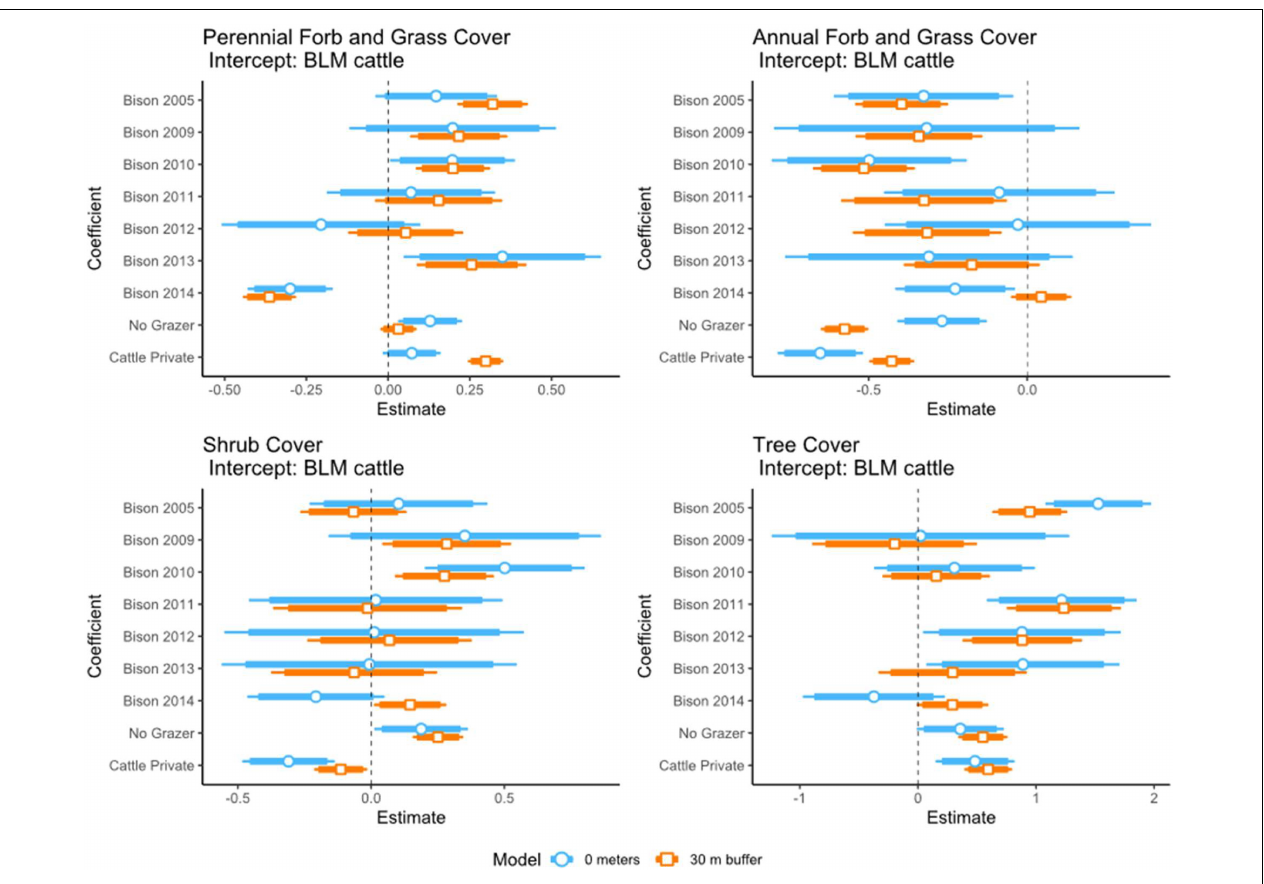
FIGURE 2 | 2019 percentage of vegetation cover in relation to grazing treatment. Intercept: BLM cattle grazed streams. Vegetation: perennial forbs and grasses, annual forbs and grasses, shrub cover, and tree cover. Treatment: BLM cattle, Bison (2005, 2009, 2010, 2011, 2012, 2013, 2014), no grazers, private lands cattle. Models were run for two distance categories: (1) 0 m from stream; (2) < 30 m from stream